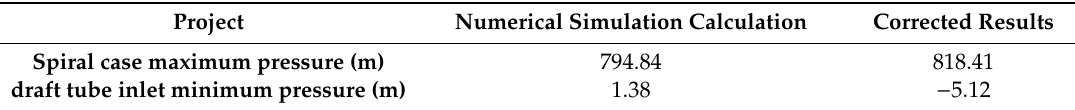
Figure 11. Pressure extreme process line of draft tube inlet under successive load rejection. Table 7. Extremum of control conditions.